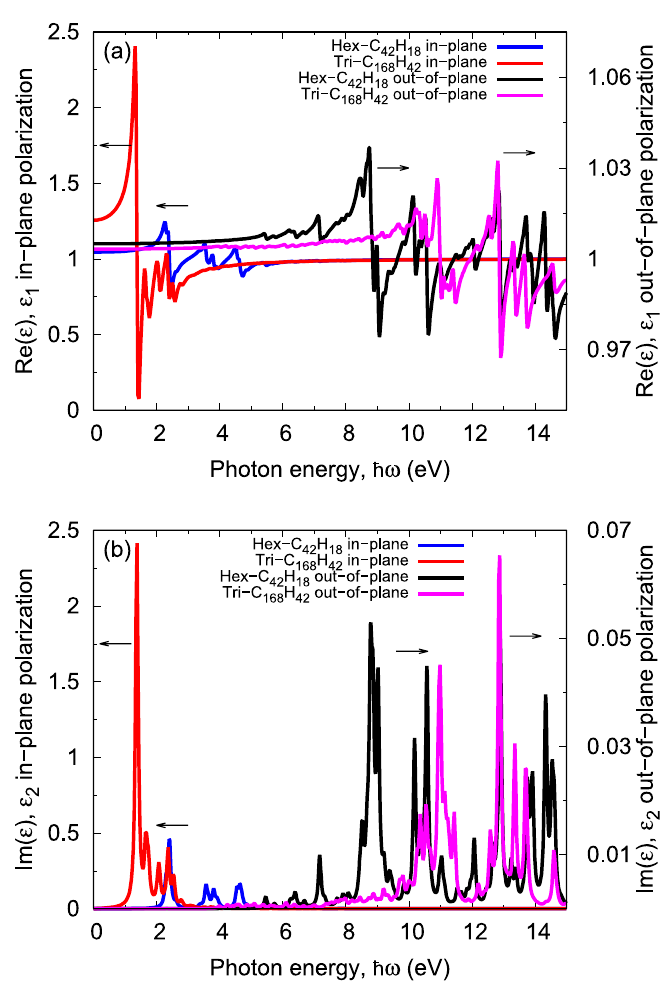
Figure 4. Spectra of the dielectric coefficients (epsilon) of monolayer GQDs for various structures and incident light polarization: ( a ) the real part of epsilon and ( b ) the imaginary part of epsilon.